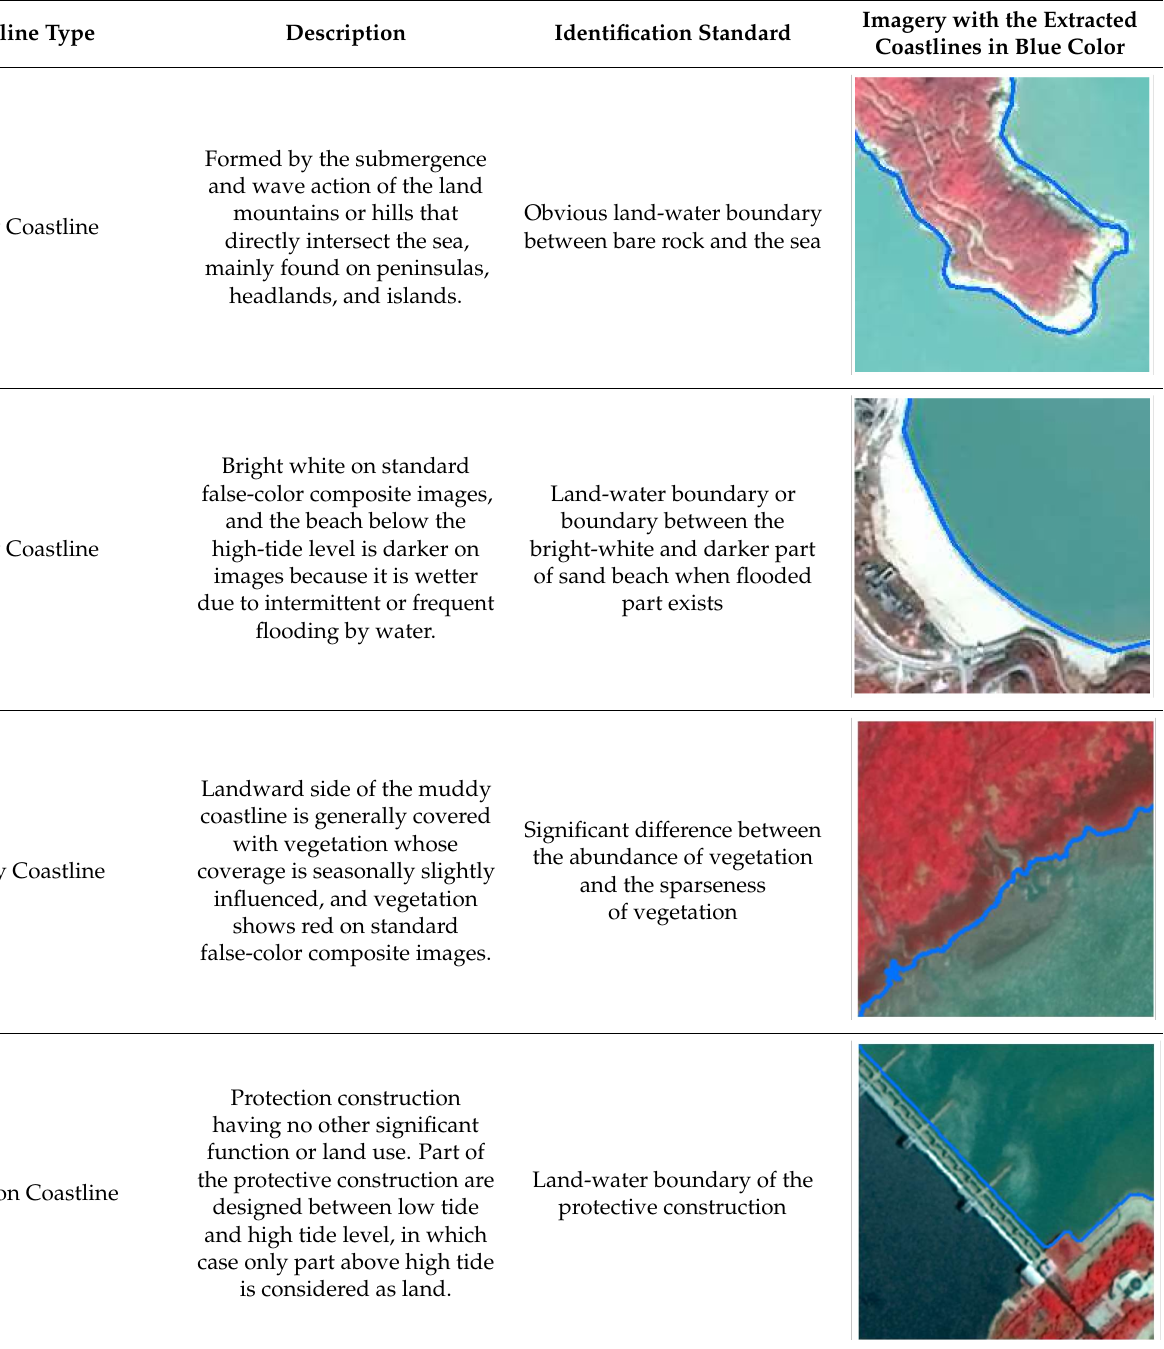
Table 1. Coastline classification system of the Yangtze River